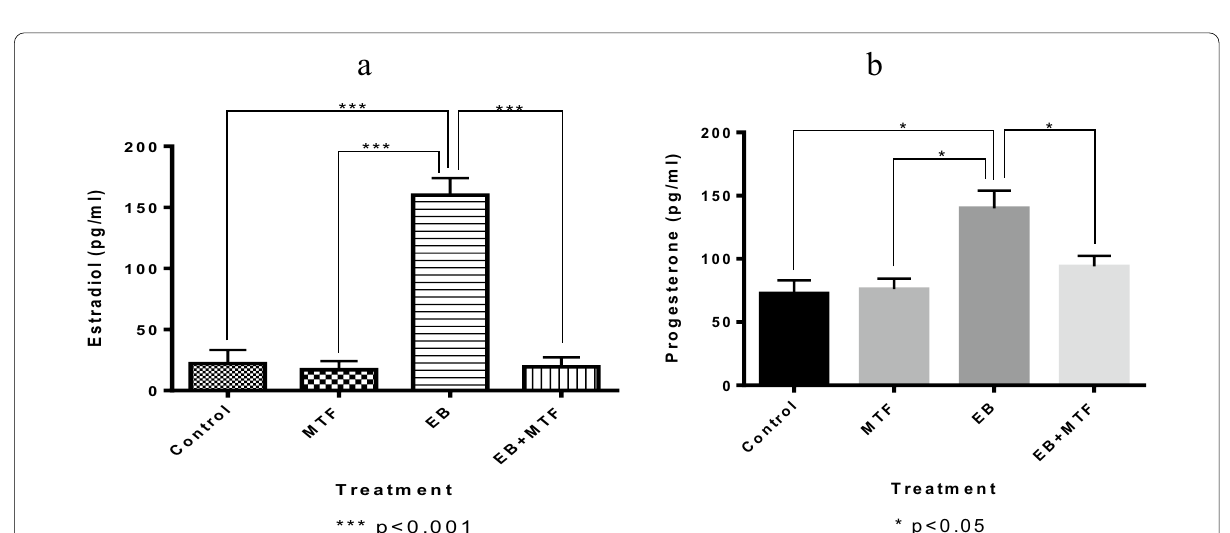
Fig. 4 Effect of oral administration of metformin on ( a ) serum estradiol and ( b ) progesterone levels in normal and EB-treated female